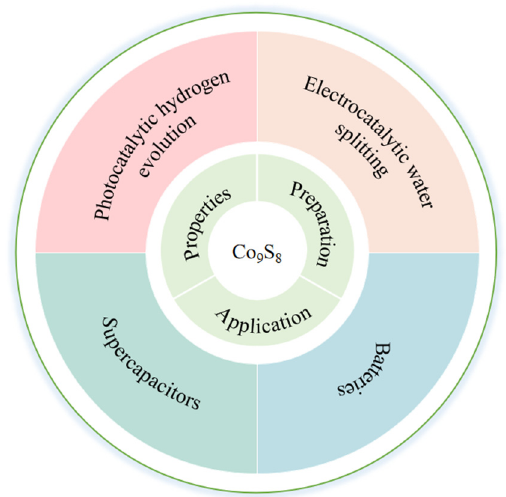
Figure 1. Properties, preparation and application (photocatalytic hydrogen evolution, electrocatalytic water splitting, batteries and supercapacitors) of Co 9 S 8 -based materials.